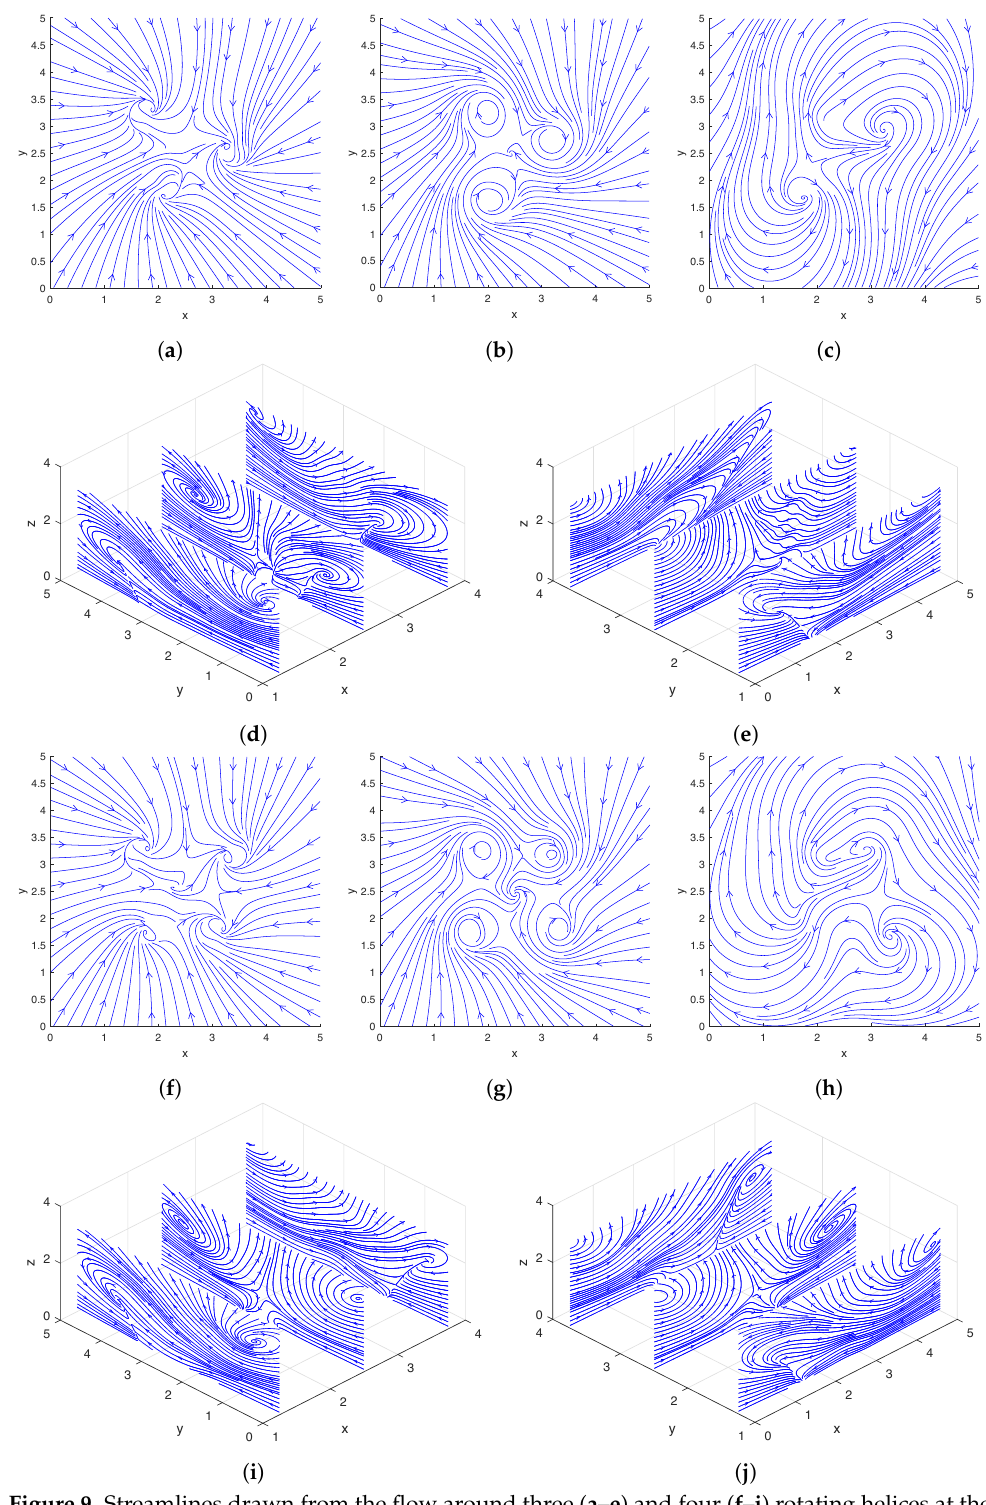
Figure 9. Streamlines drawn from the flow around three ( a – e ) and four ( f – j ) rotating helices at the midpoint of a cycle. The locations and phase shifts of the helices in the two cases are shown in Figure 10a,b respectively. ( a – c ) and ( f – h ): Streamlines plotted using only the x - and y -direction fluid veloci- ties on the slice planes located at z = 0.1 ( a , f ), z = 1.1 ( b , g ), and z = 2.5 ( c , h ). ( d , i ): Streamlines plotted using only the y - and z -direction fluid velocities on the slice planes located at x = 1.25, 2.5, 3.75. ( e , j ): Streamlines plotted using only the x - and z -direction fluid velocities on the slice planes located at y = 1.25, 2.5,